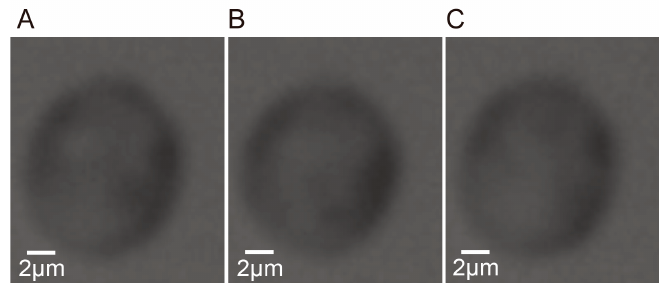
Figure 8. The determined search window of the cell of interest in the 100th frame. ( A ) The 100th frame in grayscale. ( B ) The binary difference image obtained using the threshold determined by Otsu’s method. ( C ) The resulting image when morphological opening and closing operations were applied. The radius R of the disk-shaped structural element used here is three pixels. The rectangular region surrounded by green edges is the tracked moving region of the cell of interest. ( D ) The determined search window (the rectangular region surrounded by the red edges, i.e., the dashed lines) of the cell of interest. The green edges (the solid lines) show the tracked moving region in the grayscale image.